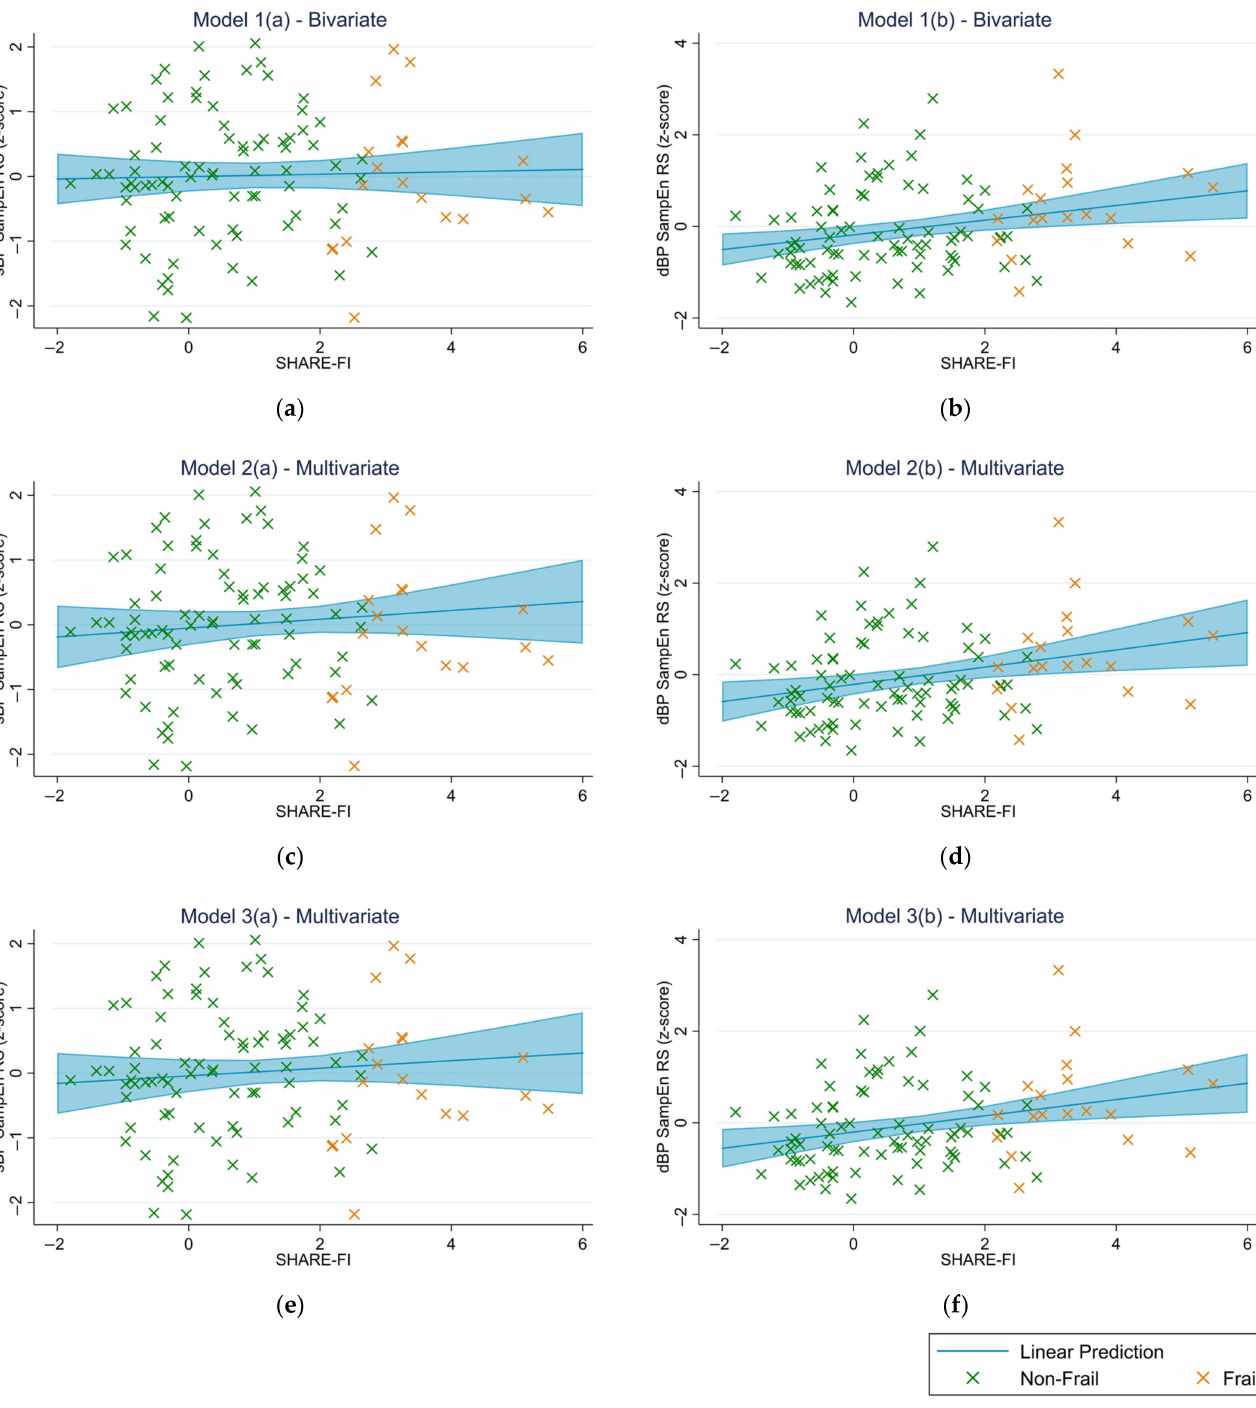
Figure 1. Margin plots illustrating the linear relationship between the continuous SHARE-FI score and BP SampEn (z-scored) from each of the models investigated. ( a , b ) show results from model 1, un- adjusted (bivariate), for systolic blood pressure (sBP) and diastolic blood pressure (dBP) respectively. ( c , d ) show results from model 2, adjusted for age, sex, CIRS-G score, and cardiovascular medication use, for sBP and dBP respectively. ( e , f ) show results from model 3, adjusted for age, sex, CIRS-G score, cardiovascular medication use, educational attainment, smoking status, alcohol consumption, and BMI, for sBP and dBP respectively. 95% confidence intervals are also shown (light blue